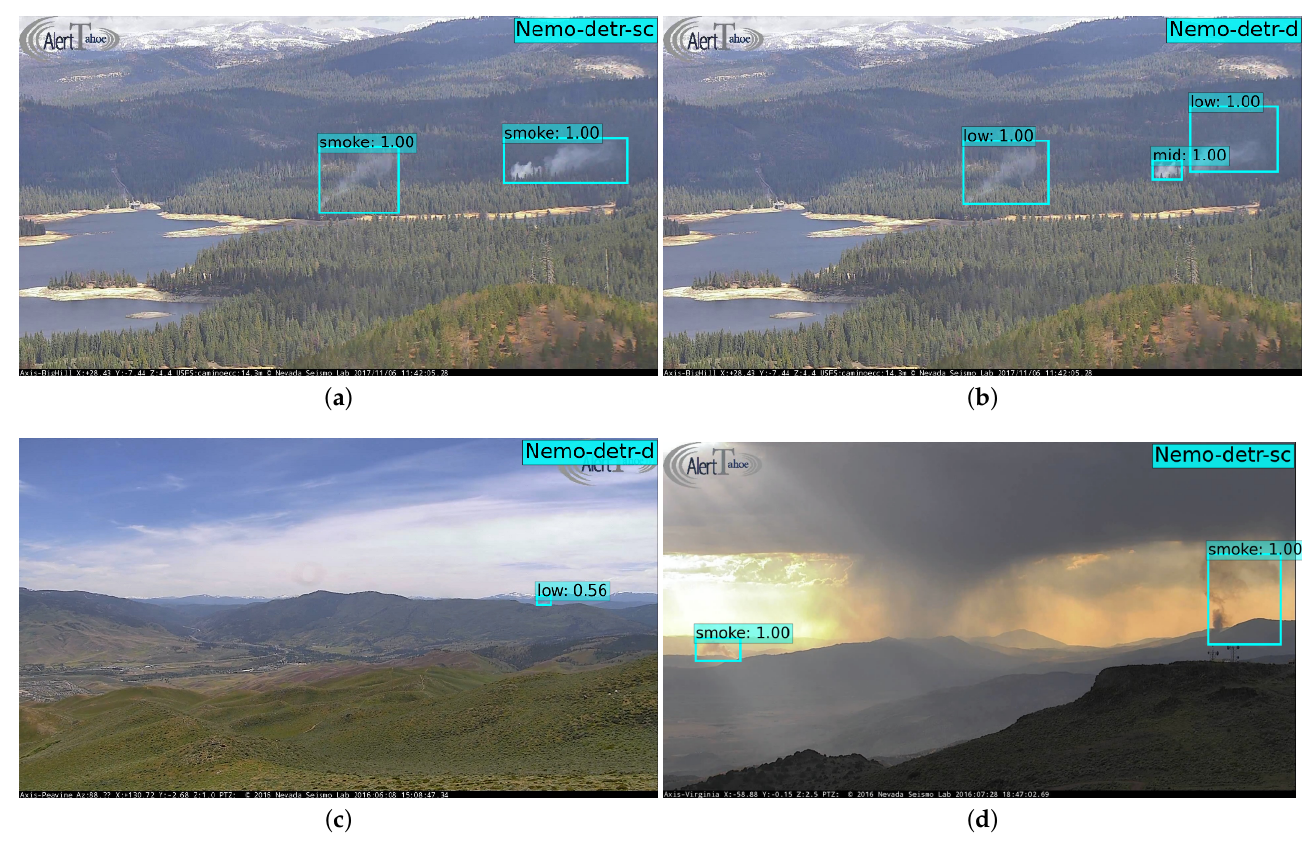
Figure 8. Representative examples of smoke detection from the models presented in Table 3. ( a , b ) show single-class and density inferences, respectively, of the same image: prescribed burns near Union Valley Reservoir seen from Big Hill Mtn, CA. ( c ) Sage Hen incident north of Truckee, CA. ( d ) Tule and Rock fire take off northwest of Virginia Peak,